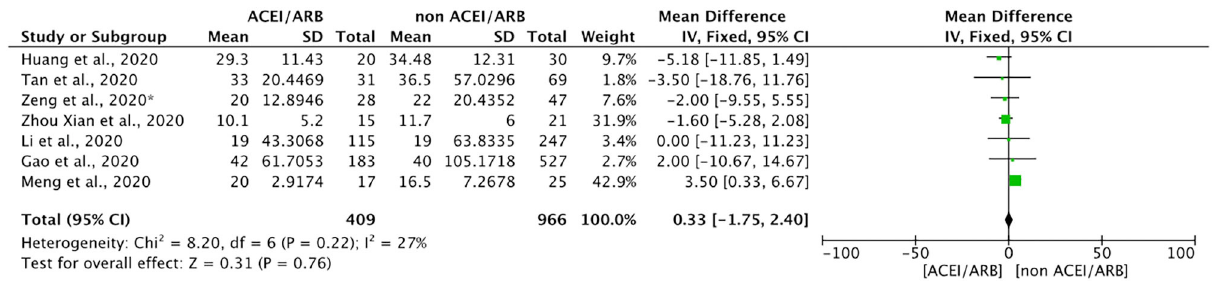
FIGURE 4 | Forest plot showing the effects of ACEIs/ARBs on hospitalization duration in patients with COVID-19. SE, standard error; IV, inverse variance; df, degrees of